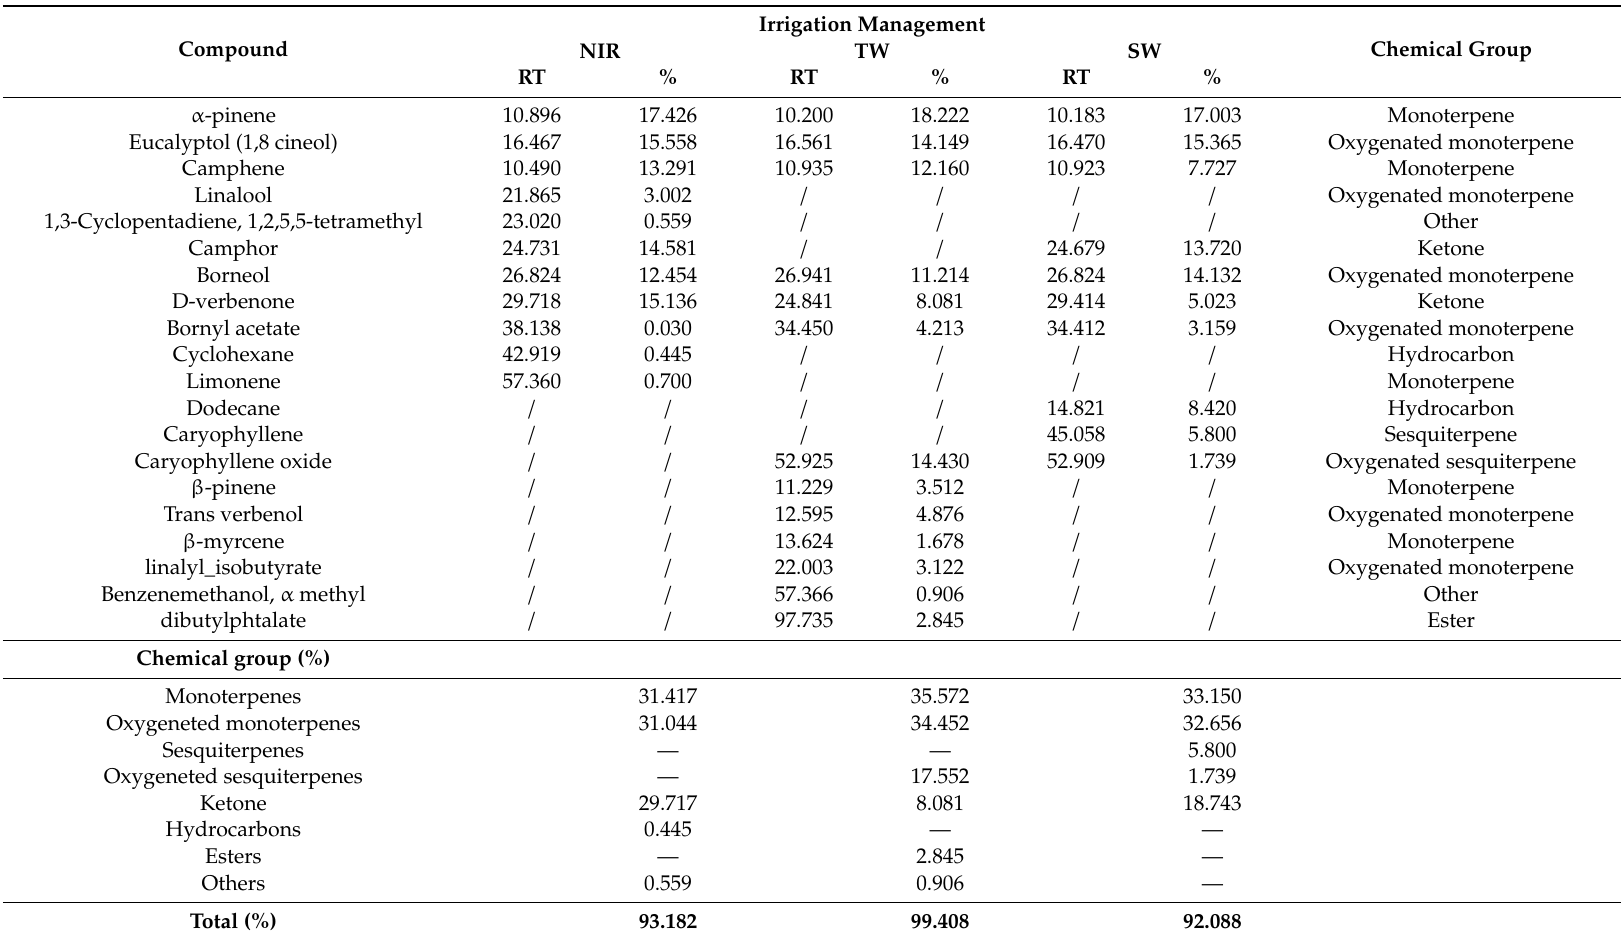
Table 2. Characterization of Rosmarinus o ffi cinalis essential oil by GC / MS from di ff erent irrigation